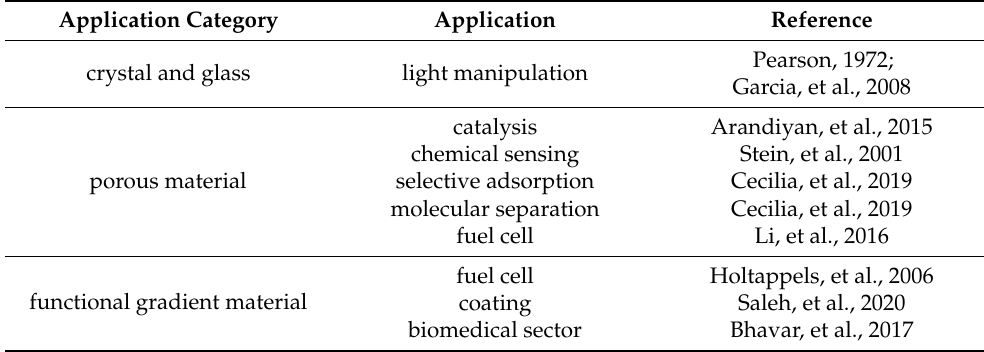
Table 1. Examples of different applications for the material fabricated by (ultra)centrifugation for